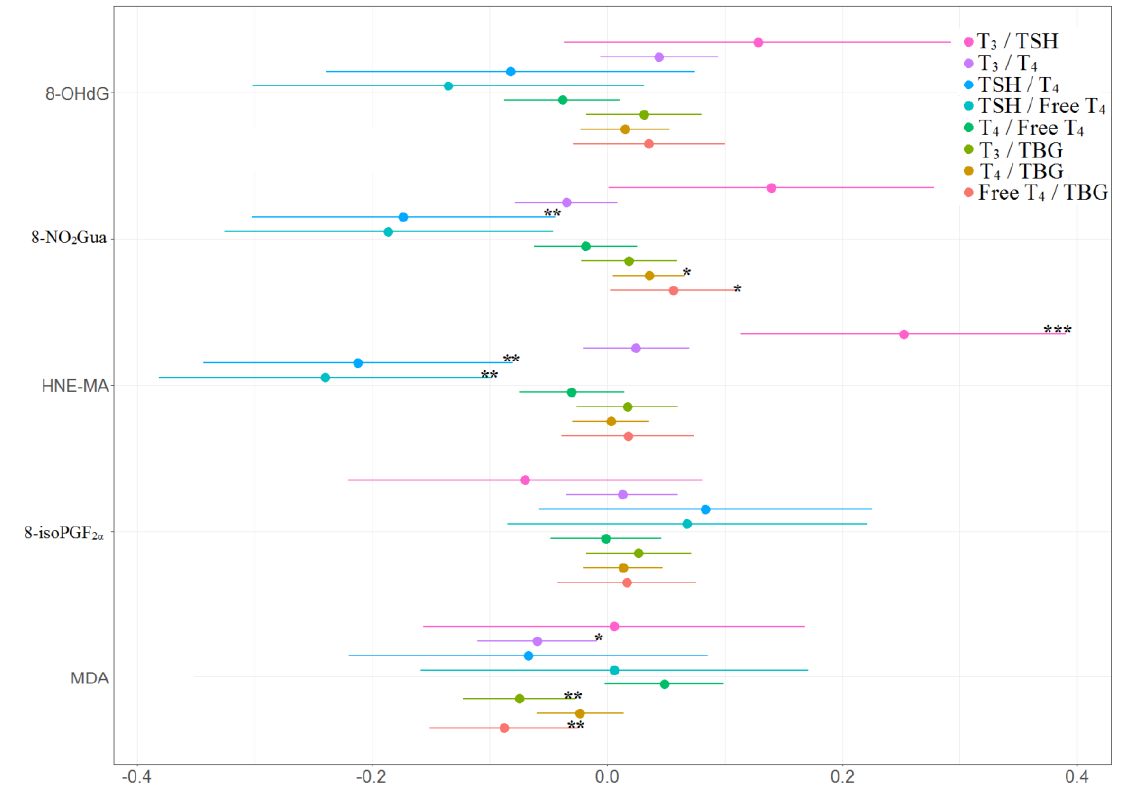
Figure 5. Percent changes in concentrations of thyroid hormone ratios in association with tertile increase in oxidative/nitrosative stress biomarkers concentrations across three visits. Linear mixed models with random intercept were adjusted for age and creatinine; * p < 0.05, ** p < 0.01, *** p < 0.001.